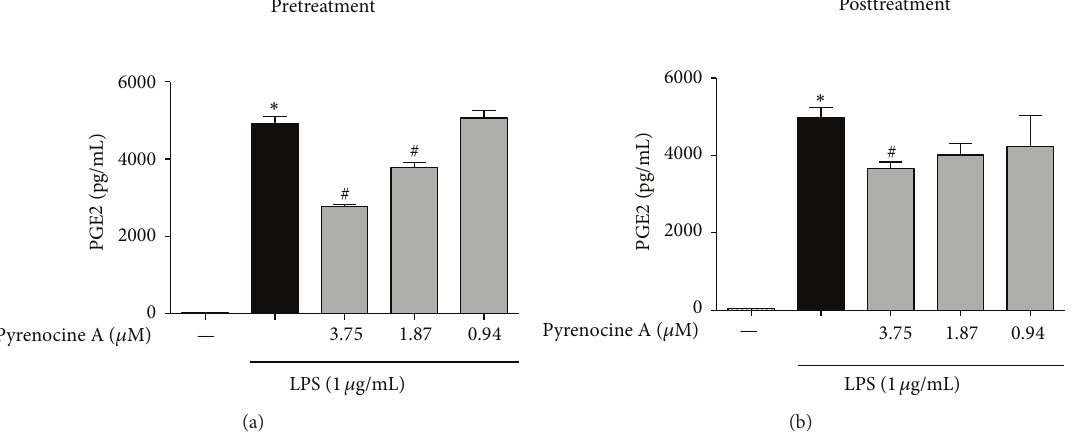
Figure 4: Anti-inflammatory effects of pyrenocine A on PGE2 production by macrophages. (a) Pretreatment procedure: cells were pretreated with different concentrations of pyrenocine A (3.75–0.94 𝜇 M) for 2 h and then stimulated with LPS (1 𝜇 g/mL) during 18 h. (b) Posttreatment procedure: cells were stimulated with LPS (1 𝜇 g/mL) for 2 h and then pyrenocine A (3.75–0.94 𝜇 M) was added during 18h. The supernatants were collected, and the production of PGE2 was evaluated. The procedures were performed in